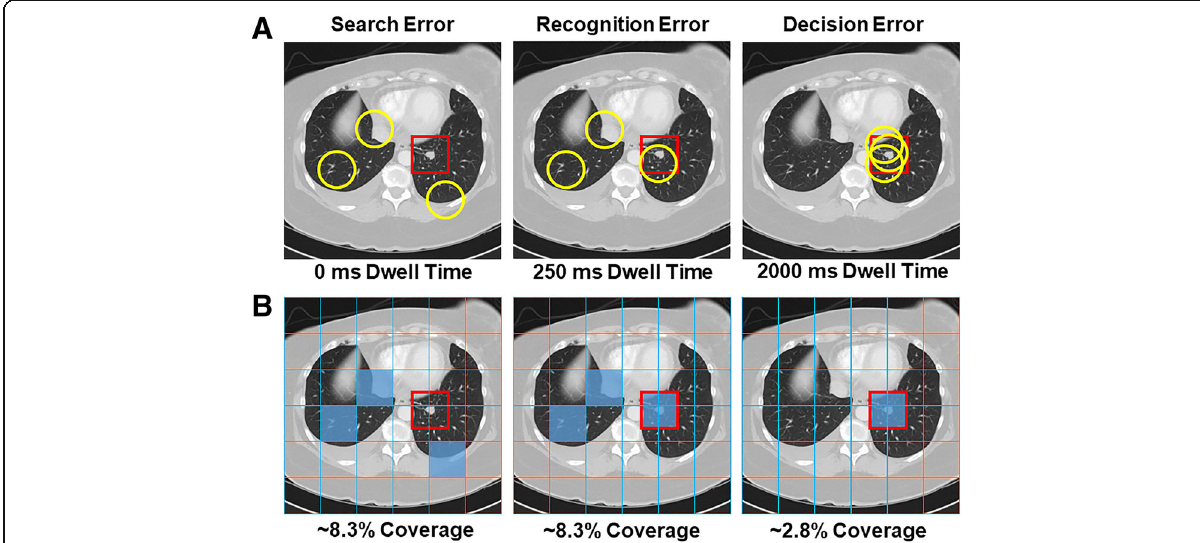
Fig. 3 a Illustration of how a missed nodule can be classified as a search, recognition, or decision error using eye-tracking. Yellow circles represent fixations and the red square represents the region of interest for the abnormality. b Example of image coverage